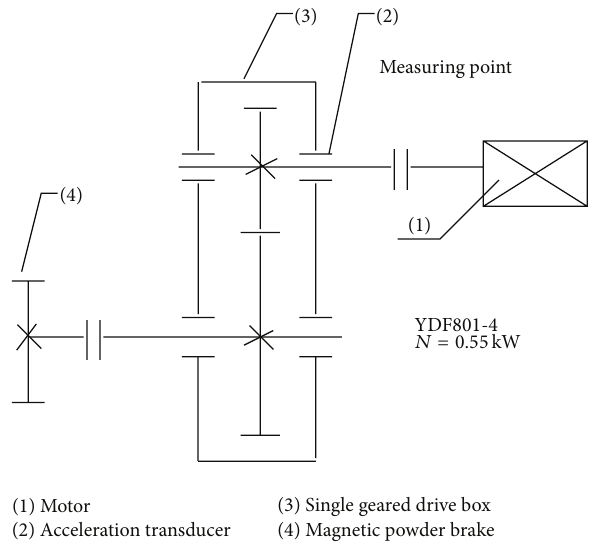
Figure 4: The schematic diagram of the experimental setup.